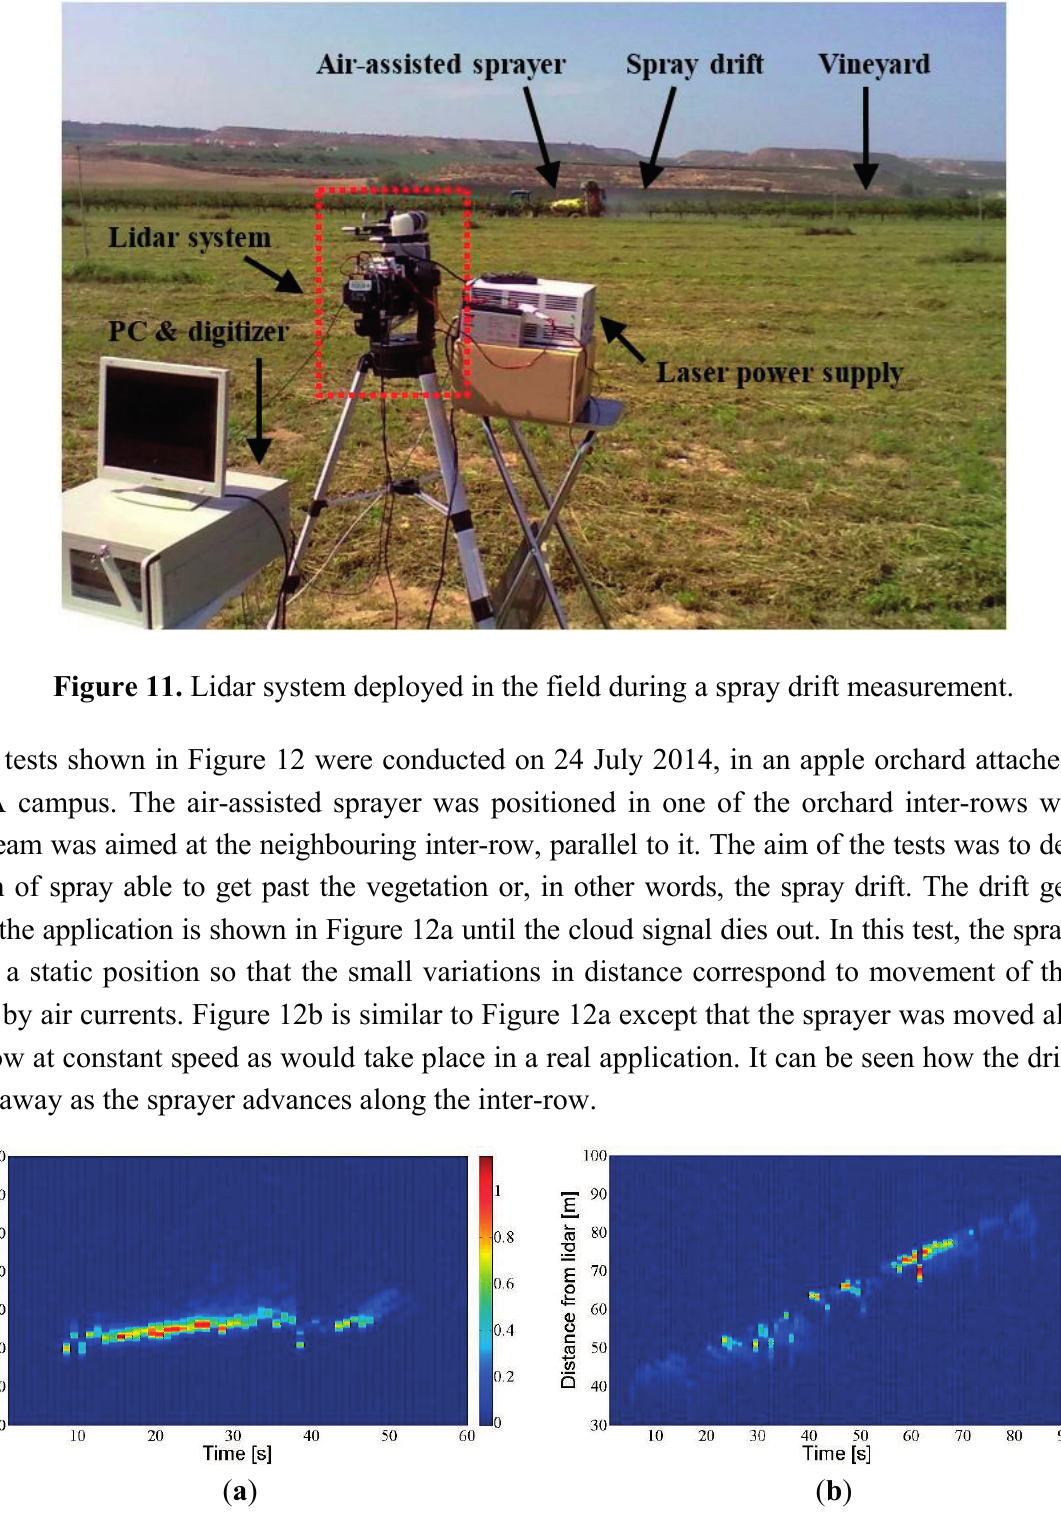
Figure 12. Detection of the pesticide spray drift in an apple orchard. ( a ) RTI plot corresponding to the sprayer in a static position; ( b ) RTI plot with the sprayer in movement with a constant